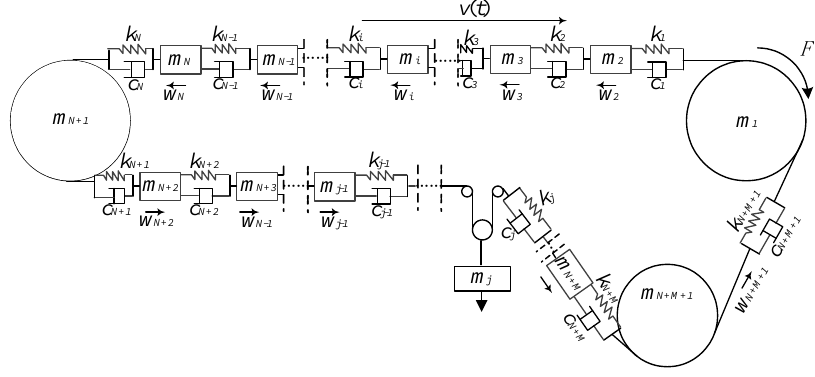
Figure 6. A discrete closed-loop model of the belt conveyor system.